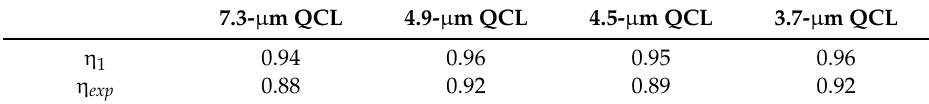
Table 3. Theoretical coupling efficiencies into the lowest-order mode η 1 and experimental η ext values.